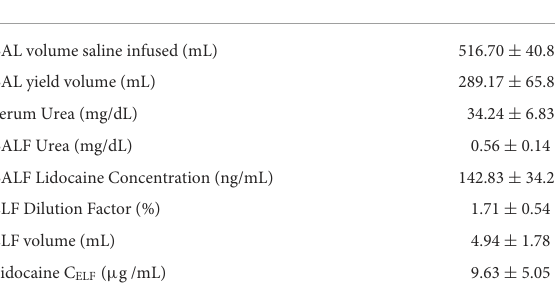
TABLE A Pulmonary concentrations of lidocaine after nebulization of lidocaine 1mg/kg in 6 healthy